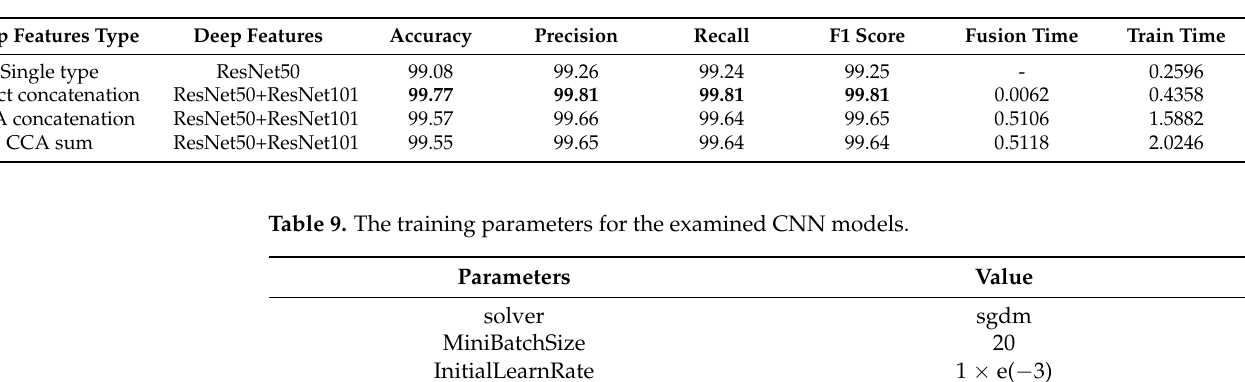
Table 8. The best performance comparison between single deep feature and different fusion method (bold font shows the best performance).